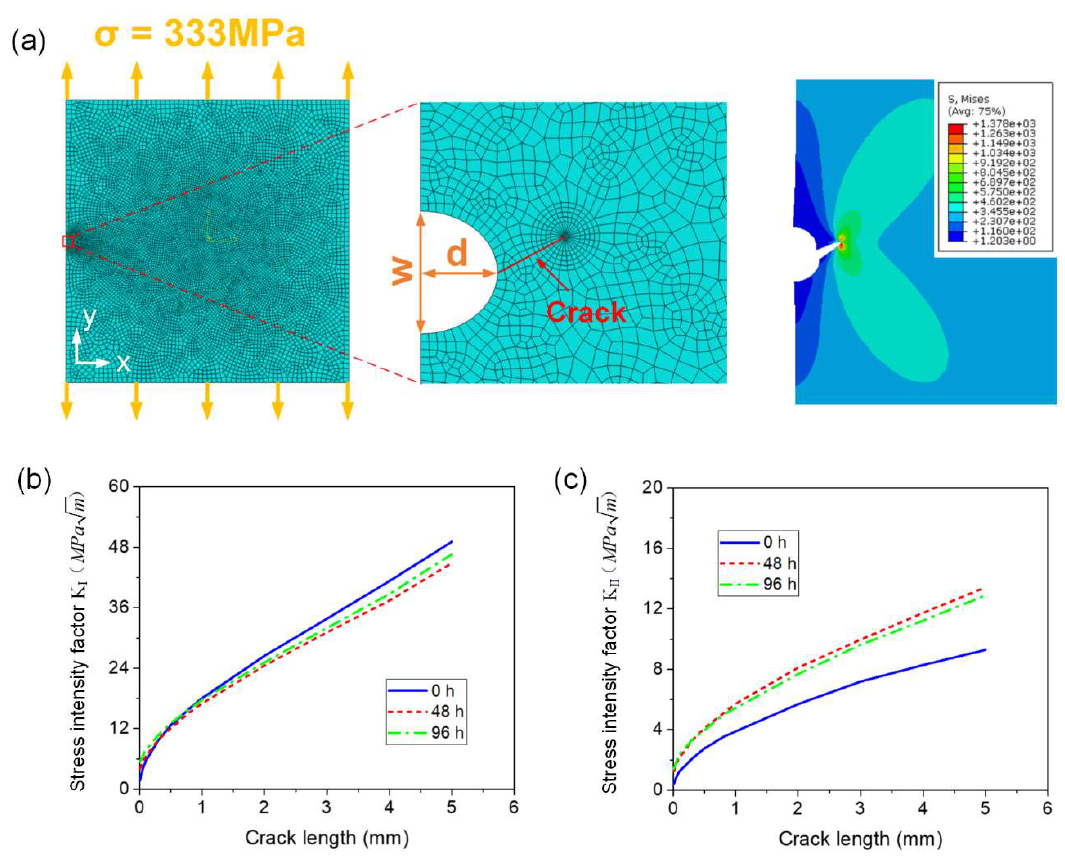
Figure 15. ( a ) Schematic diagram of SIF calculation by Abaqus, ( b ) Calculated Mode-I SIF curves versus crack length for specimens with different corrosion times, ( c ) Calculated Mode-II SIF curves versus crack length for specimens with different corrosion times.